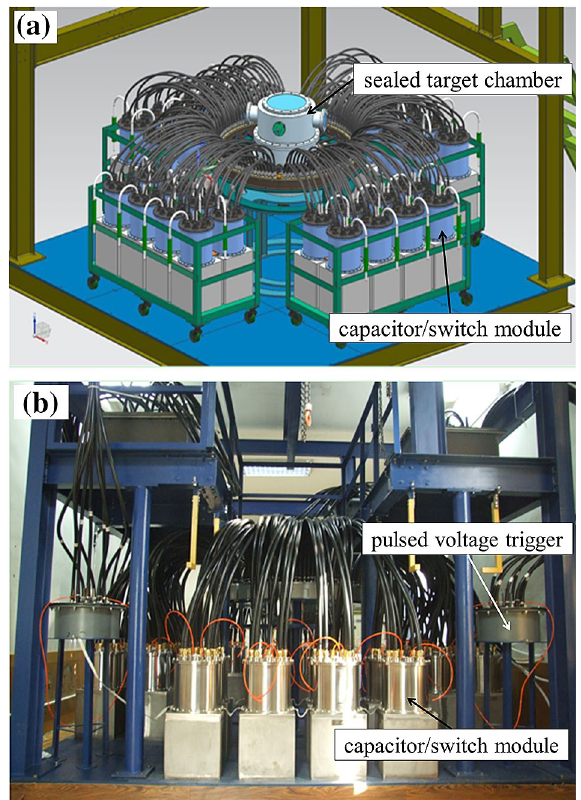
Figure 1. ( a ) Conceptual design and ( b ) photograph of the CQ-3